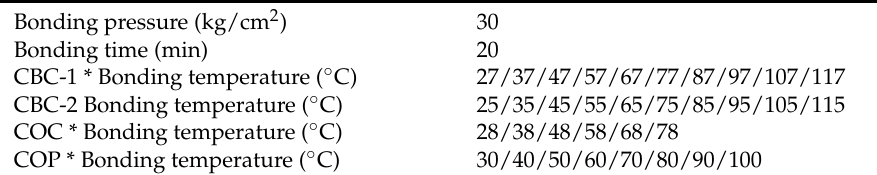
Table 1. Thermal fusion bonding process